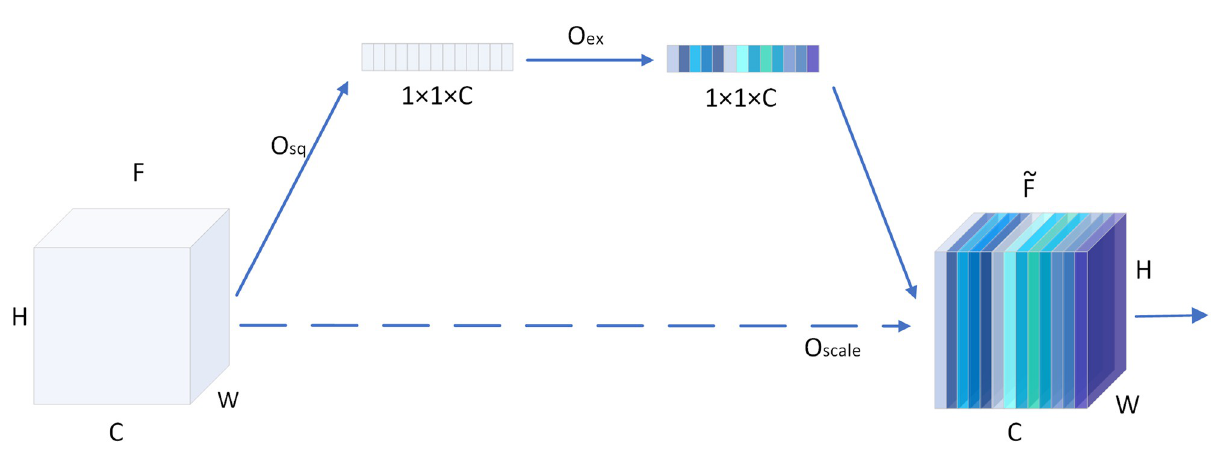
Fig 3. Illustration of